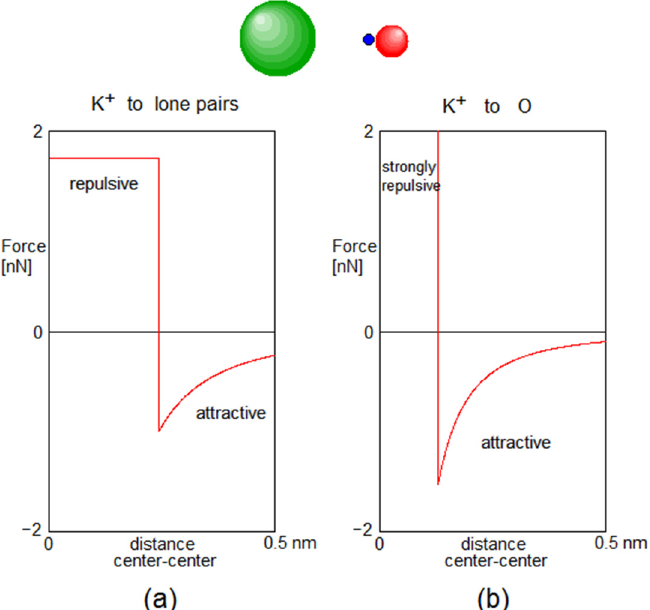
Figure A2. Force between a K + ion and the oxygen atom of a carbonyl group. As we modeled the oxygen atom as two-point charges, where one also carries mass (the actual O-atom), and the other no mass but only a charge (the center point of the lone pairs charge distribution) one must consider separately the force between the lone-pair electrons of the oxygen atom and the K + (picture (a)) and the force between the actual oxygen atom and the K + (picture (b)). ( a ): When the positive K + approaches the negative electron lone-pairs point charge, there is a mutual attractive force due to the Coulomb interaction, which can reach almost 10 − 9 N. At a center-center distance of the two charges of 0.238 nm, however, the strong but constant repulsion of orbital overlap sets in, with a magnitude of about 1.7 × 10 − 9 N, which corresponds to an energetic cost of full overlap of K + and the electron lone-pairs charge density cloud of 100 k B T (T = 310 K). ( b ): When the positive K + approaches the negatively charged main body of the oxygen atom, the Coulomb force is attractive and reaches a value of about 1.5 × 10 − 9 N. At center-center distances of K + and O of less than 0.124 nm the orbitals (other than the lone-pair electrons of the oxygen) begin to overlap and a very strong and constant repulsion of 1.72 × 10 − 8 N sets in, which corresponds to an energetic cost of 500 k B T for full overlap of K + and O. During the simulations, however, this repulsion never occurs, because the K + are constrained to the central axis of the selectivity filter and never get close enough to the oxygen atoms.